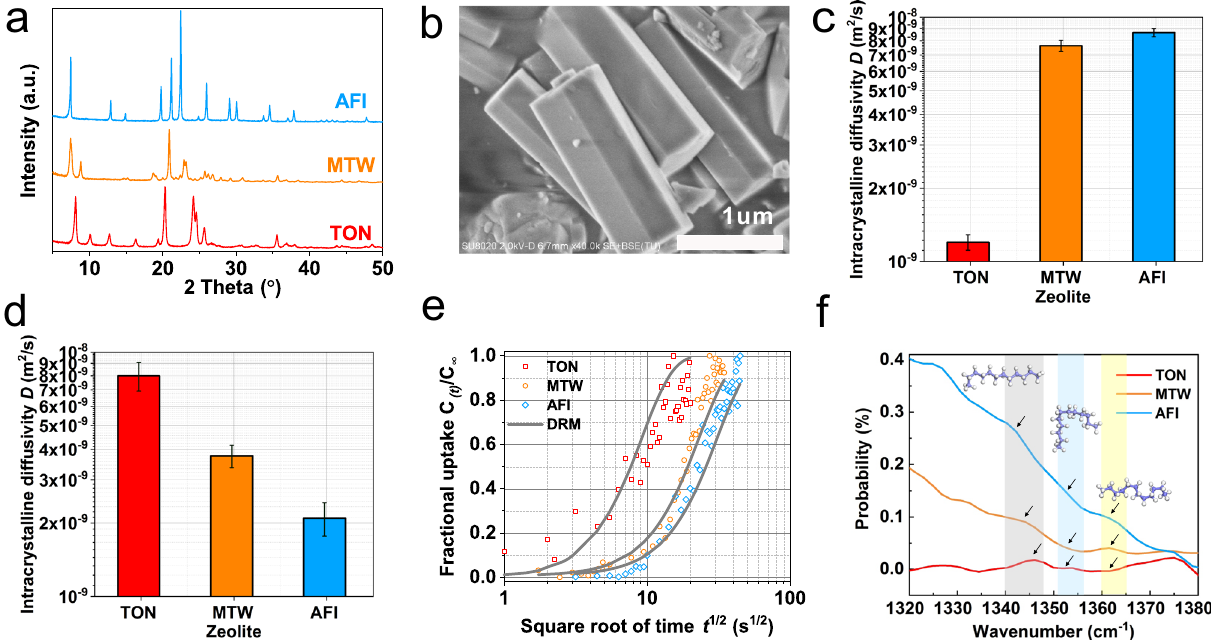
Fig. 5| Experimentalresults forC4 and C12 diffusioninthe zeolites.a The XRD patternsoftheTON,MTW,andAFIzeolites. b SEMpicturesoftheAFIzeolite, c The uptakecurveandintracrystallinediffusivityof d C4and e C12(errorbarrepresents the experimental fi tting error). f Infrared spectroscopy of the n-dodecane